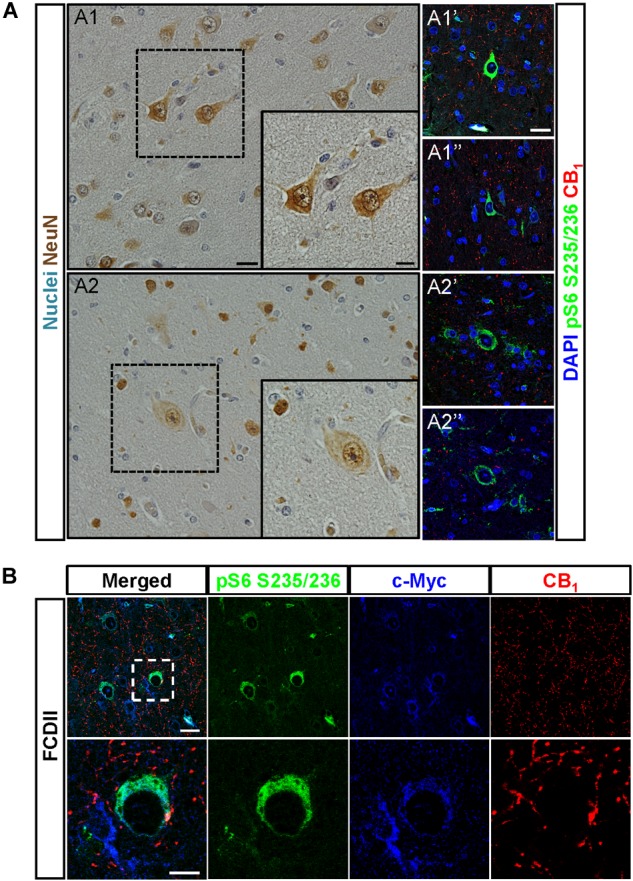
CB1 receptors are present in undifferentiated cells. (A) Dysplastic neurons (A1,A1′,A1″) and balloon cells (A2,A2′,A2″) were identified based in morphological criteria in hematoxylin/eosin sections stained with NeuN antibody (A1,A2). CB1 receptor expression and mTORC1 activity status were analyzed by immunofluorescence with CB1 and phospho-S6 antibodies, respectively (A1′,A1″,A2′,A2″). (B) Representative immunofluorescence images showing the presence of CB1 receptor (red) in FCD Type II brain cells labeled with the undifferentiated cell marker c-Myc (blue) and active mTORC1 signaling phospho-S6+ cells (green). High magnification insets are shown (lower panels). Scale bar: 25 μm, insets, 10 μm.